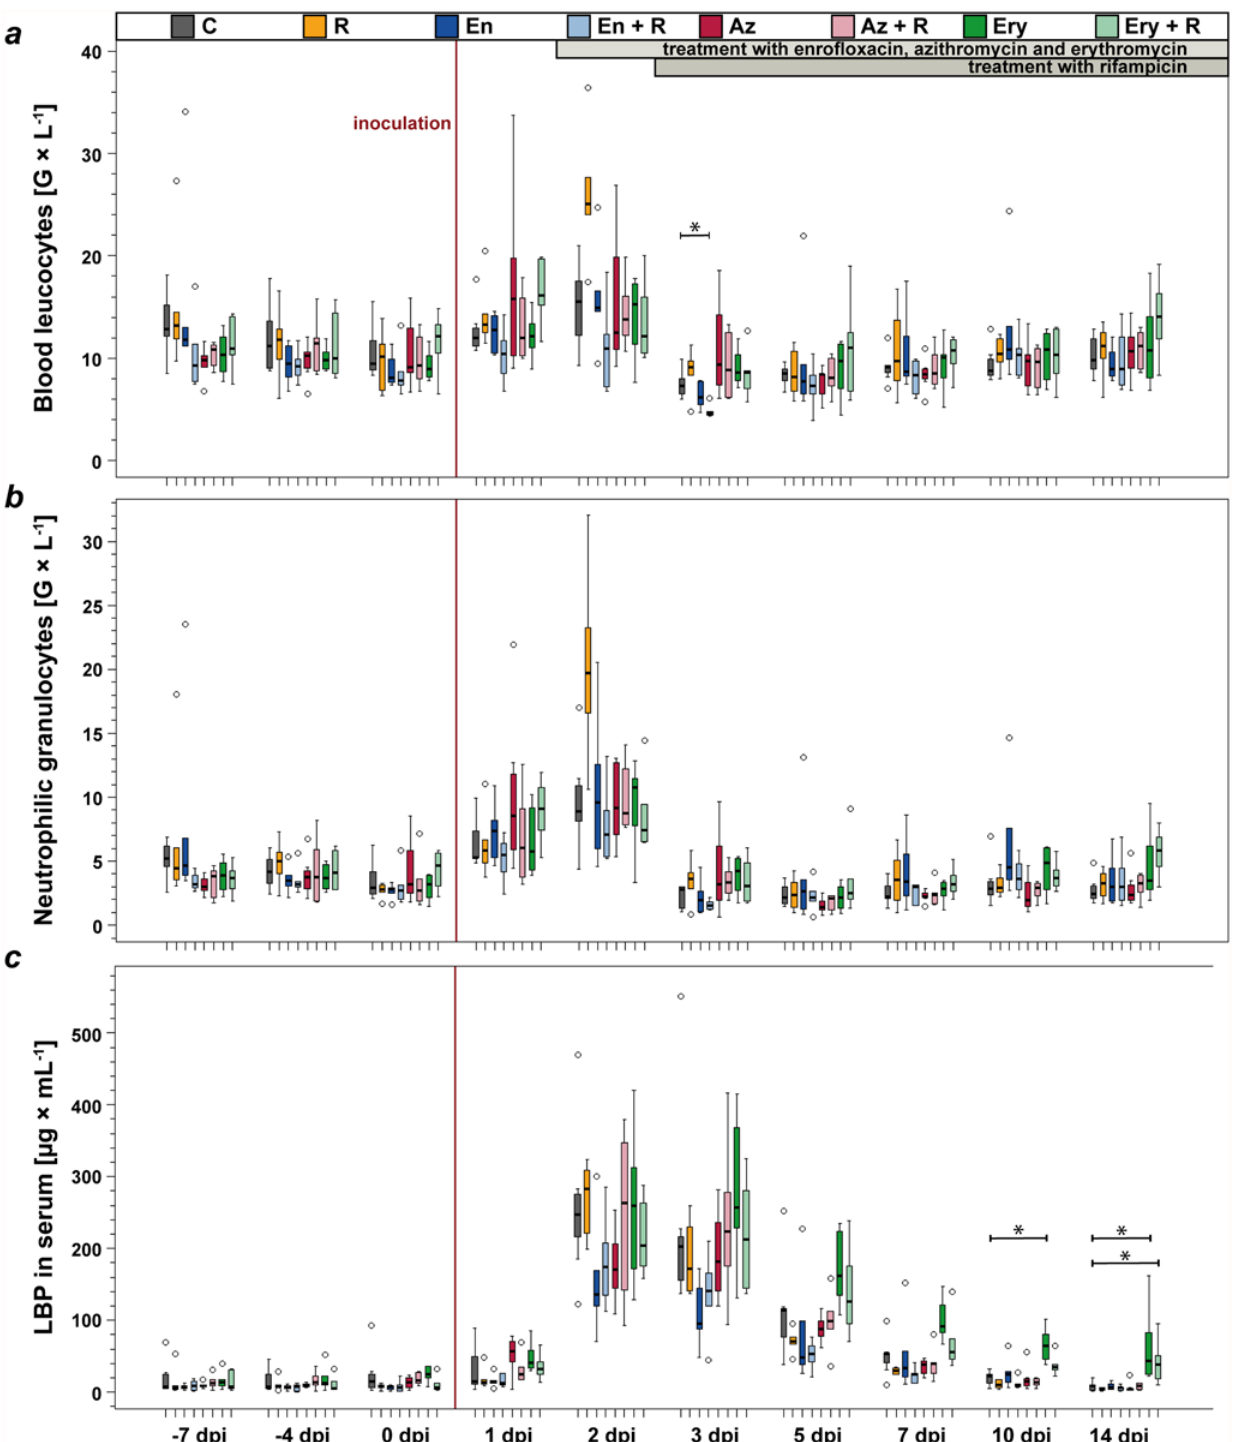
Fig 4. Blood parameters. The day after inoculation with Chlamydia psittaci , total blood leucocyte numbers (a) were already markedly increased and numbers stayed above baseline level 2 dpi. The initial increase was followed by a drop slightly below baseline level in all groups. Neutrophilic granulocytes (b) were the cell population being mainly responsible for the changes in absolute leukocyte numbers after inoculation. Other than in the group treated with enrofloxacin + rifampicin on 3 dpi, total leukocyte numbers did not differ significantly between treated and untreated animals, nor did numbers of neutrophilic